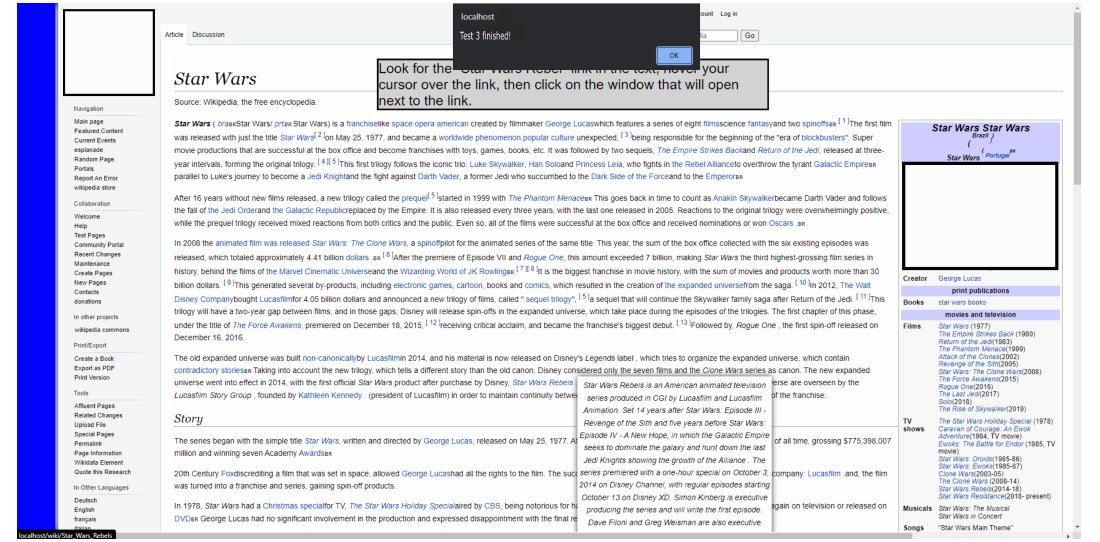
Figure 12. Final state of the task in scenario 3 [59].